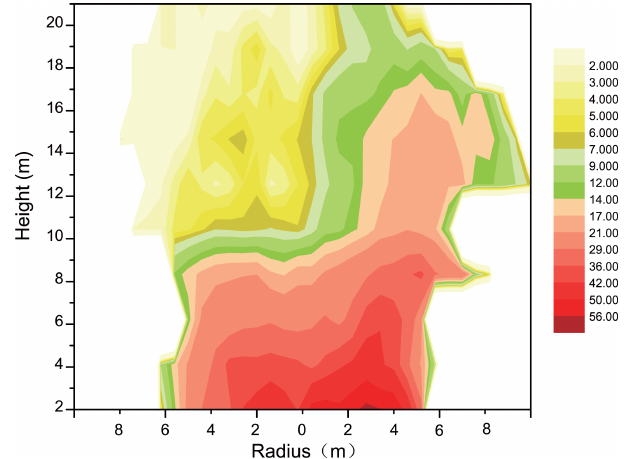
Figure 4. Horizontal variation of the DD’s opacity (%) at different